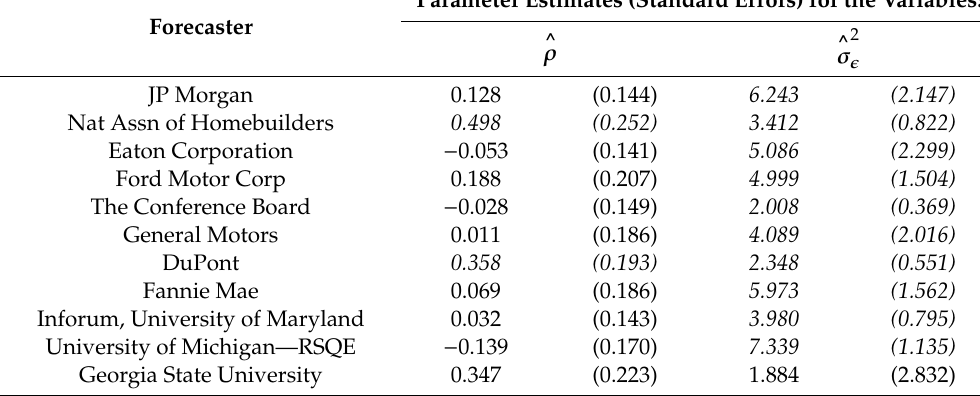
Table 2. Estimation results for (1) for forecasting inflation, USA, 1996–2018. Italics means significant at the 10% level.